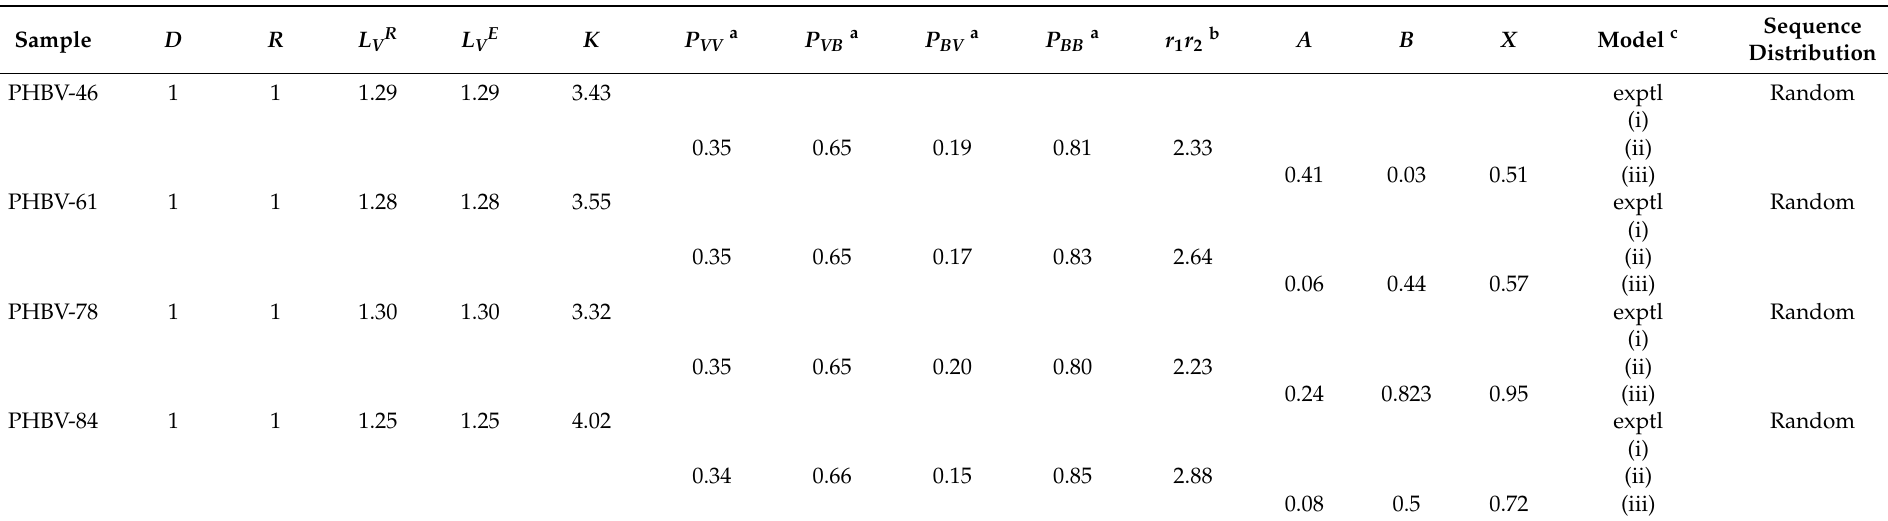
Table 6. Parameters D , R , experimental number average sequence lengths of HV units ( L VE ), number average sequence length of randomly distributed HV units in copolymer ( L VR ), ratio between the concentration of HV and HB units ( k ), four conditional probabilities ( Pij’s ) and the reaction index ( r 1 r 2 ) for PHBV operational days 46, 61, 78 and